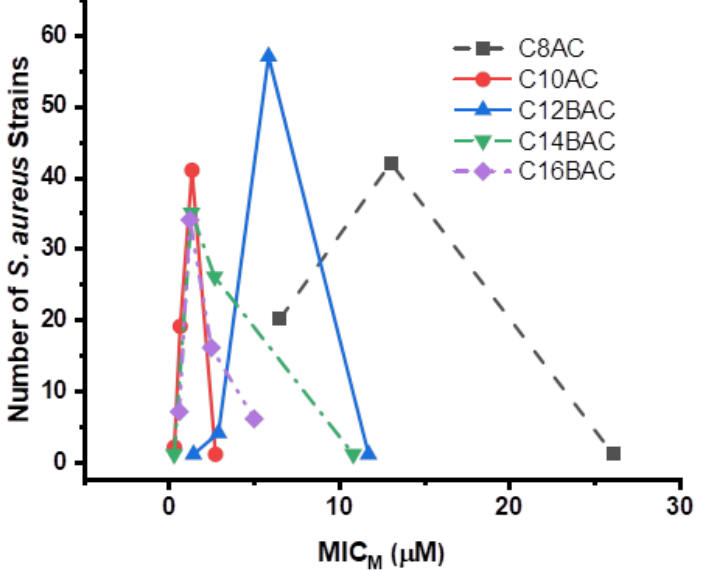
Figure 1. The number of Staphylococcus aureus strains at each molar MIC (MIC M ) for the 63 Staphylococcus aureus strains isolated from swine feces against five ammonium chloride disinfectant components.